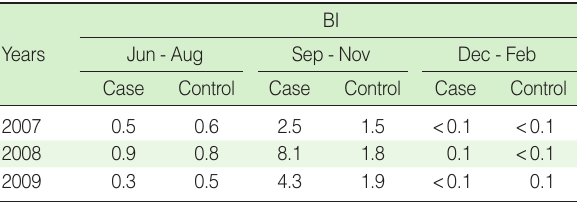
Table 5. Mean Breteau index (BI) before, during, and after dengue outbreaks in East Delhi (2007-2009) BI Jun - Aug Sep - Nov Dec - Feb Years Case Control Case Control Case Control 2007